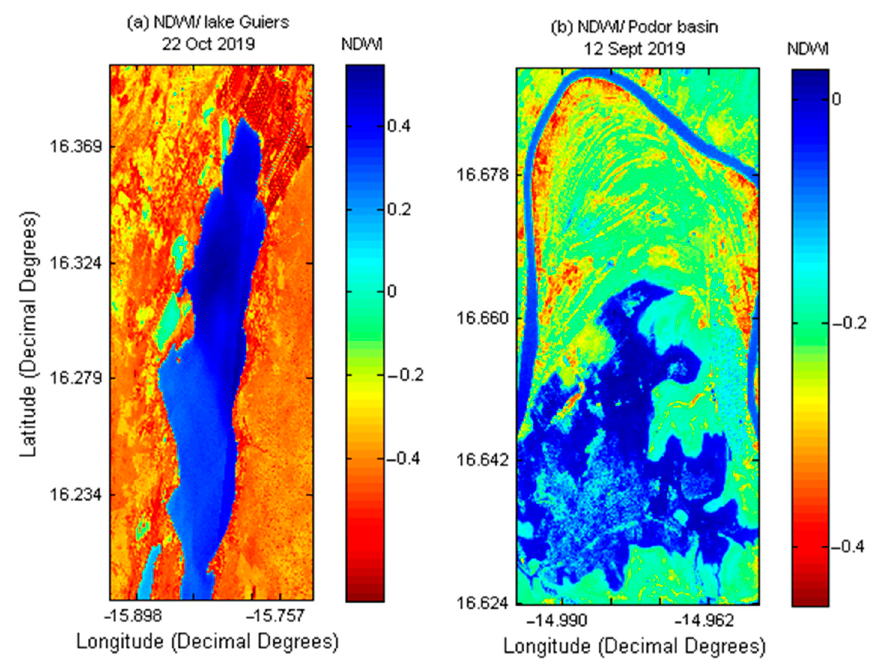
Figure 4. Use of Normalized Difference Water Index (NDWI) tested on the images of Lake Guiers ( a ) and Podor basin ( b ). (In Figure 4b, a portion of the river is included due to the constraints of area’s cutting shape).